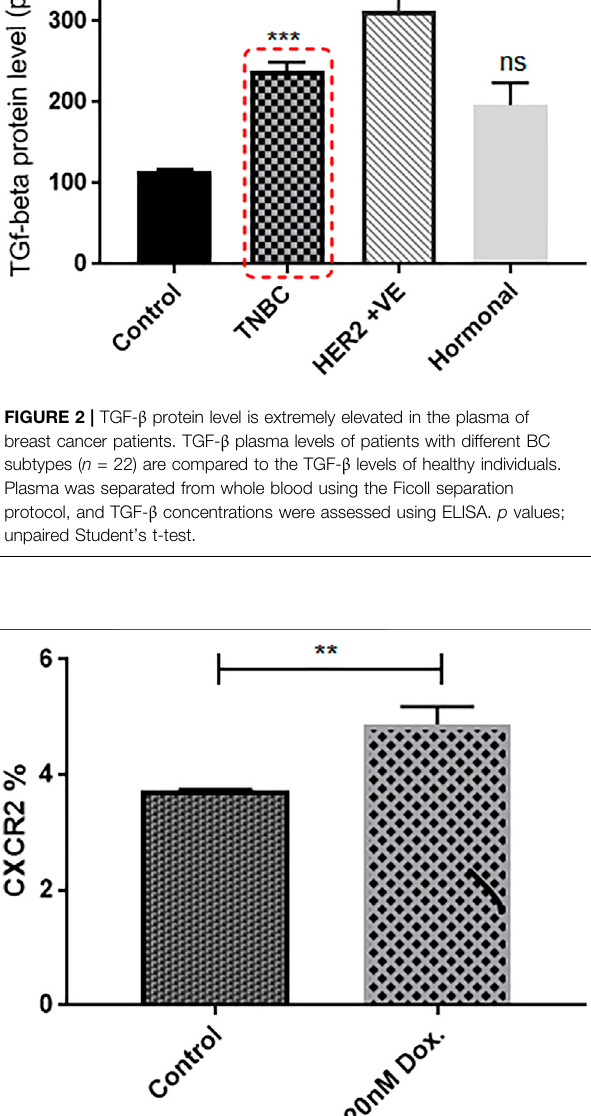
TGF- β . The TGF- β level in the supernatant of the culture treated with 320 nM doxorubicin was estimated using ELISA and was compared to the TGF- β level of the nontreated culture. Statistically signi fi cant upregulation in TGF- β was found in the coculture treated with doxorubicin compared to untreated coculture ( p < 0.0001) ( Figure 5 ).